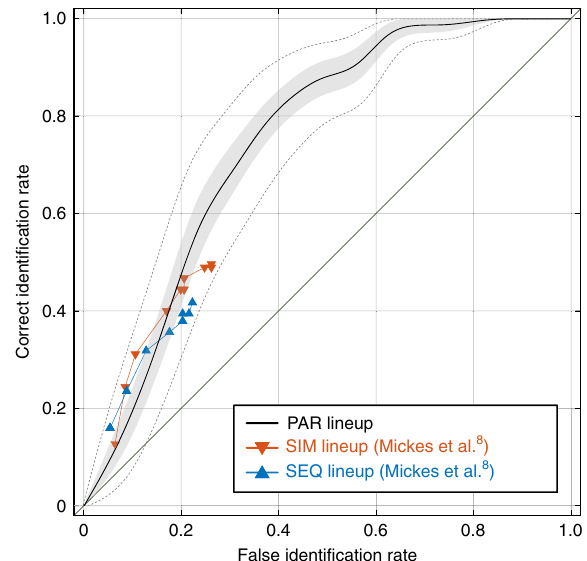
Fig. 7 Signal detection analysis of recognition memory in the group of all subjects. The black curve is a nonparametric estimate of the recognition receiver operating characteristic (recognition ROC) of collective subject performance in our paired comparison lineup (PAR). Correct identi fi cation rate, plotted on the ordinate, is derived from analysis of data obtained from the target-present condition ( N = 62 subjects). False identi fi cation rate, plotted on the abscissa, is derived from analysis of data obtained from the target-absent condition ( N = 70 subjects). Gray shaded region contains 50% error of the estimate (computed as described in Methods). Dashed lines bound a region that contains 95% error of the estimate (equivalent to the 95% con fi dence region; see Methods). Data plotted in orange (down- pointing triangles) and cyan (up-pointing triangles) are partial ROCs of collective subject performance in simultaneous (SIM) and sequential (SEQ) lineups obtained by Mickes et al. 8